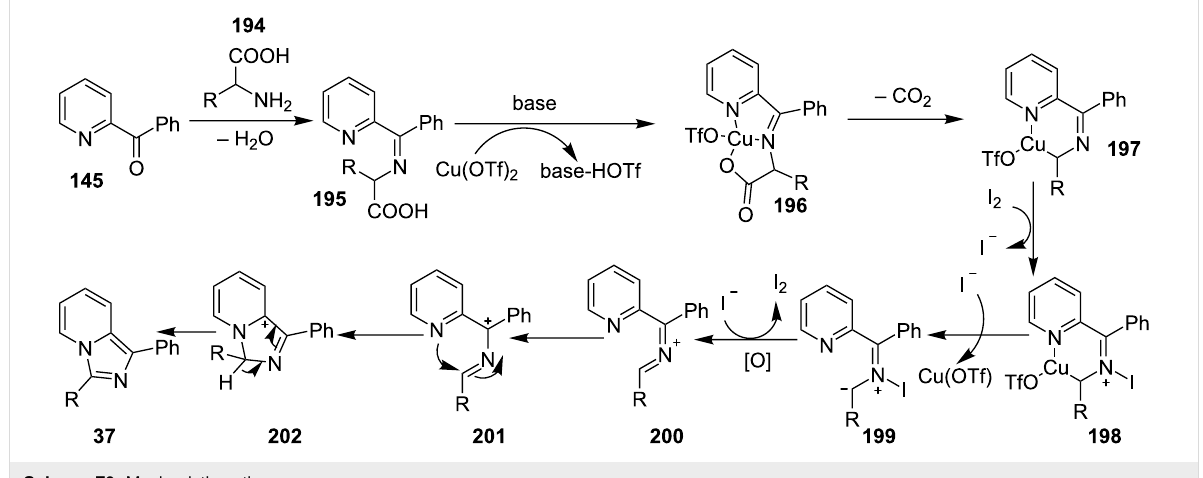
Scheme 70: Mechanistic pathway.